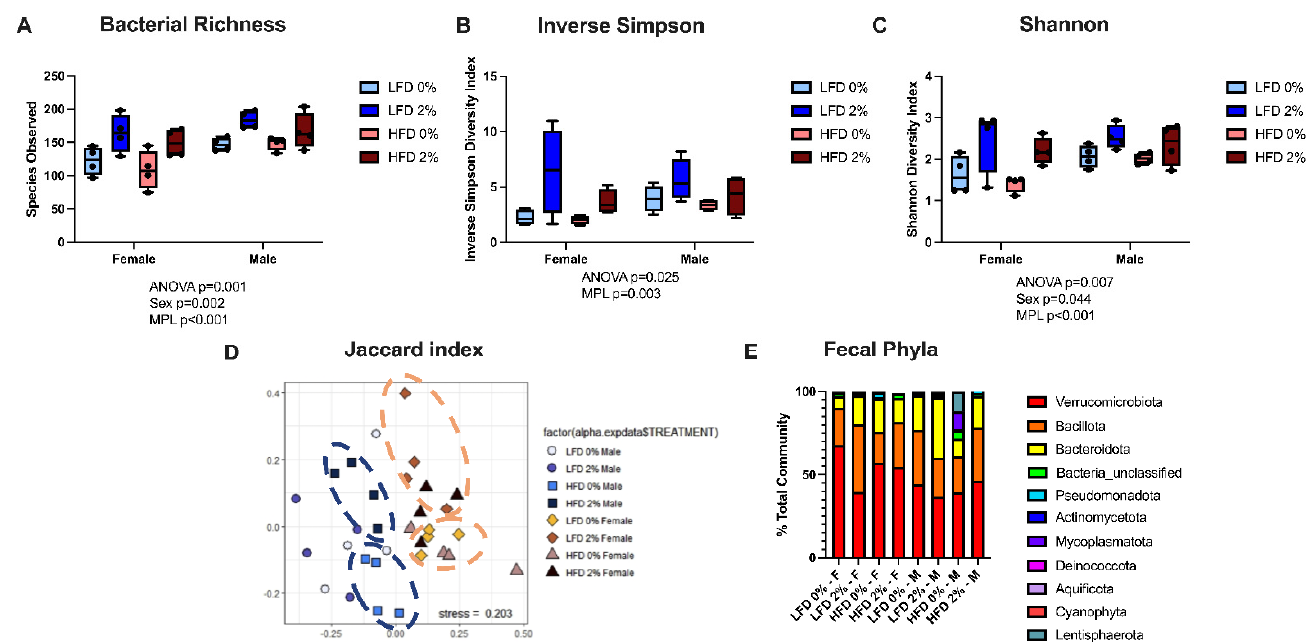
Figure 5. MPLs increase fecal microbial diversity. Cecal feces were collected and analyzed using 16S rRNA sequencing (n = 4/group). Alpha diversity ( A – C ), beta diversity ( D ), and relative abundance at phylum ( E ) are shown. Diversity measures were analyzed via nonmetric multidimensional scaling and taxa comparisons were analyzed via three-way ANOVA with Fisher’s Least Significant Difference for multiple comparisons.